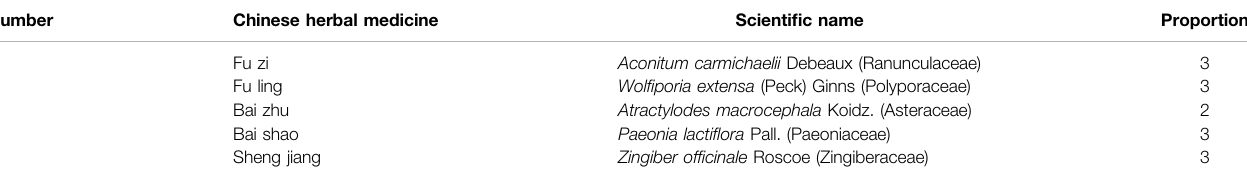
TABLE 3 | Constituents of